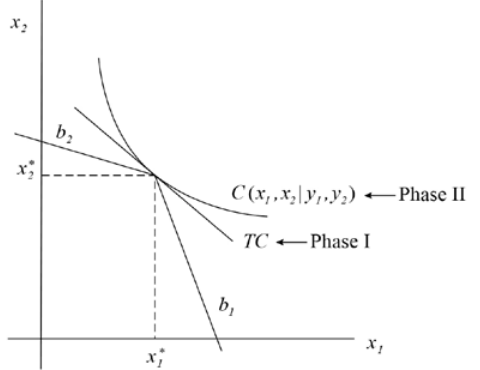
Figure 1. Phase I and Phase II estimates of decision variables x and input shadow prices y